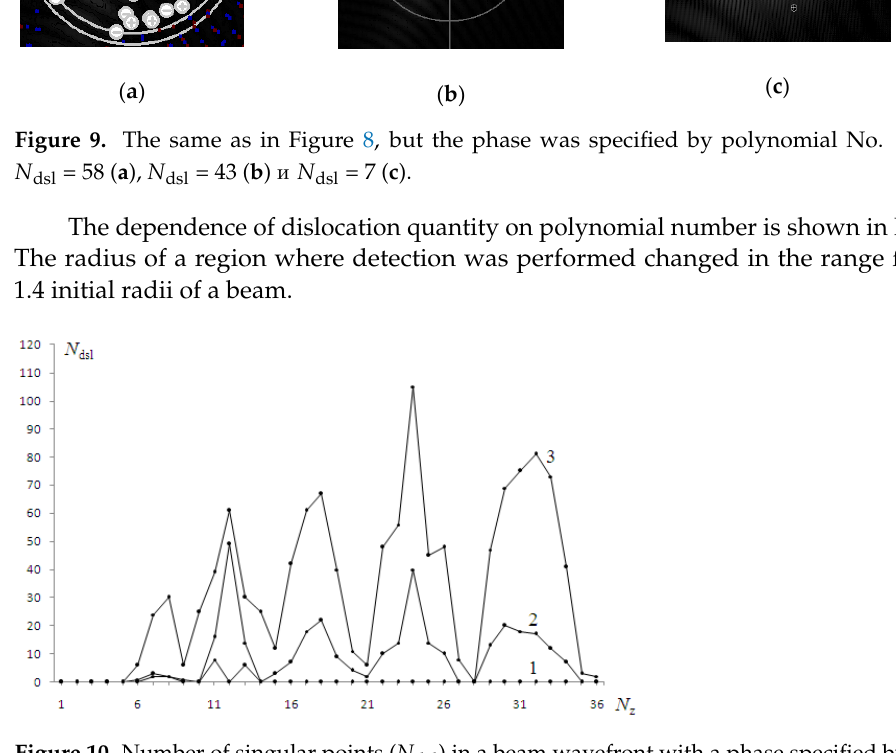
Figure 10. Number of singular points ( N dsl ) in a beam wavefront with a phase specified by different polynomials ( N z ). Registration was carried out in a region with a radius equal to the initial radius of a beam (curve 1), to two initial radii (2), to three initial radii (3). Z = 0.1.